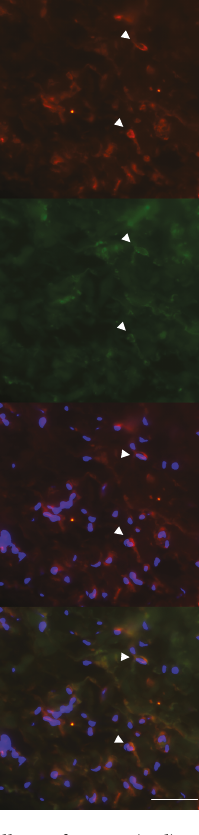
Figure 4: Double-labelling of PAI-1 (red) and CD68 (green) in an irradiated artery. Arrowheads indicate colocalization of PAI-1 and CD68, suggesting that PAI-1 is expressed in macrophages. Arrows indicate cells with PAI-1 expression but no CD68 expression. Nuclear stain (DAPI) is shown in blue (scale bar =50 μ m).